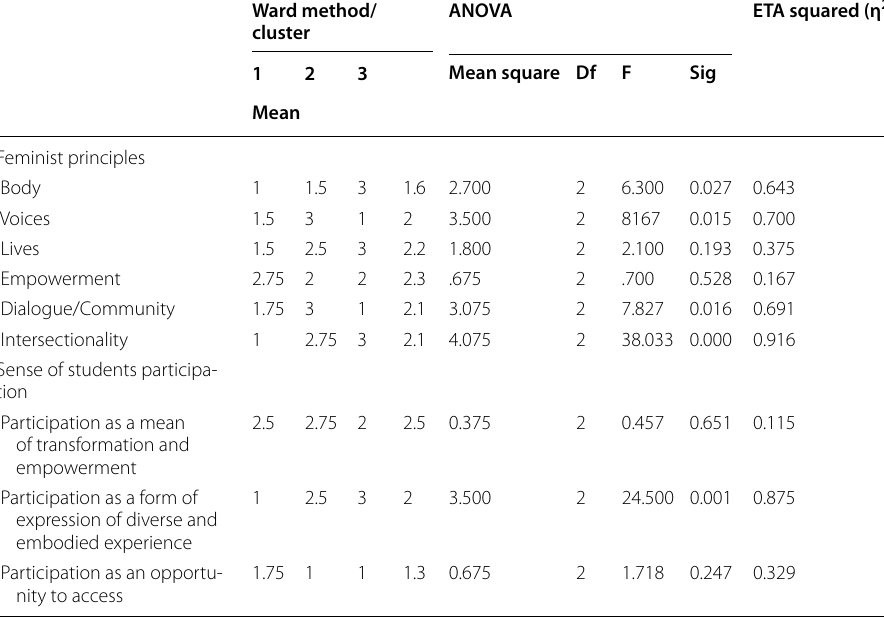
Ward method/ cluster